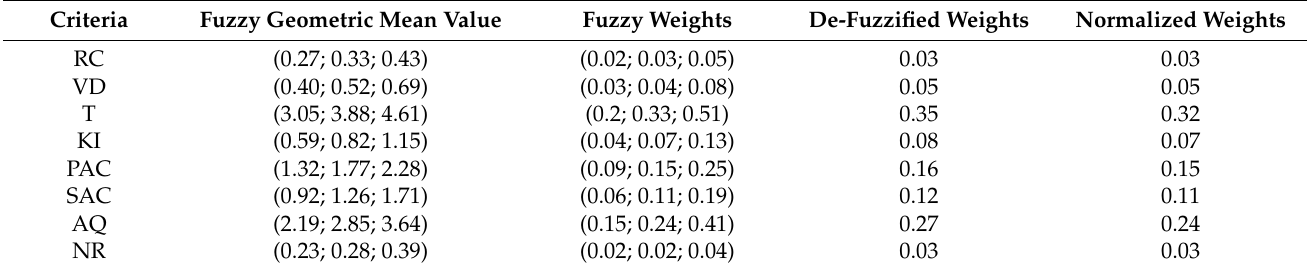
Table 6. From fuzzy to normalized